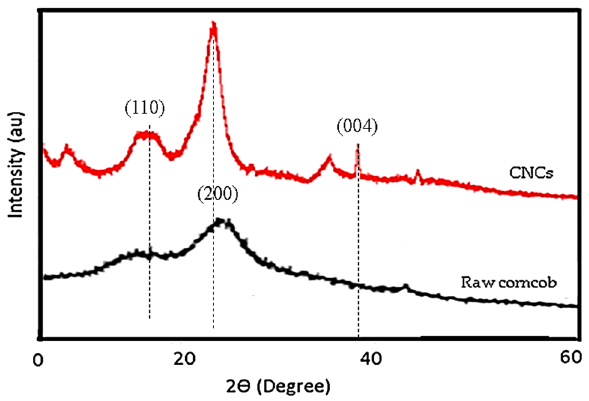
Figure 4. X-ray diffractogram of raw corncob and synthesized